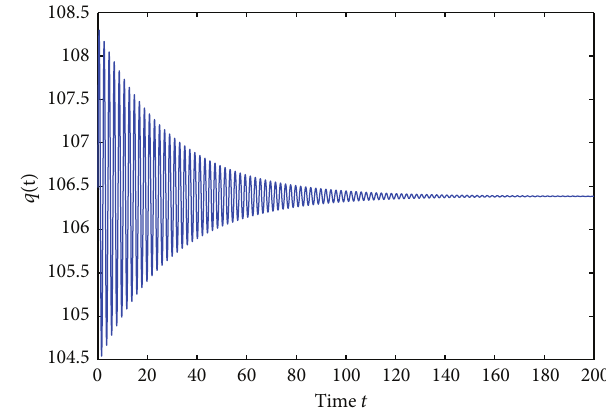
Figure 1: Waveform plot of 𝑡 - 𝑥(𝑡) with 𝜏 = 0.200 . Figure 2: Waveform plot of 𝑡 - 𝑞(𝑡) with 𝜏 = 0.200 .